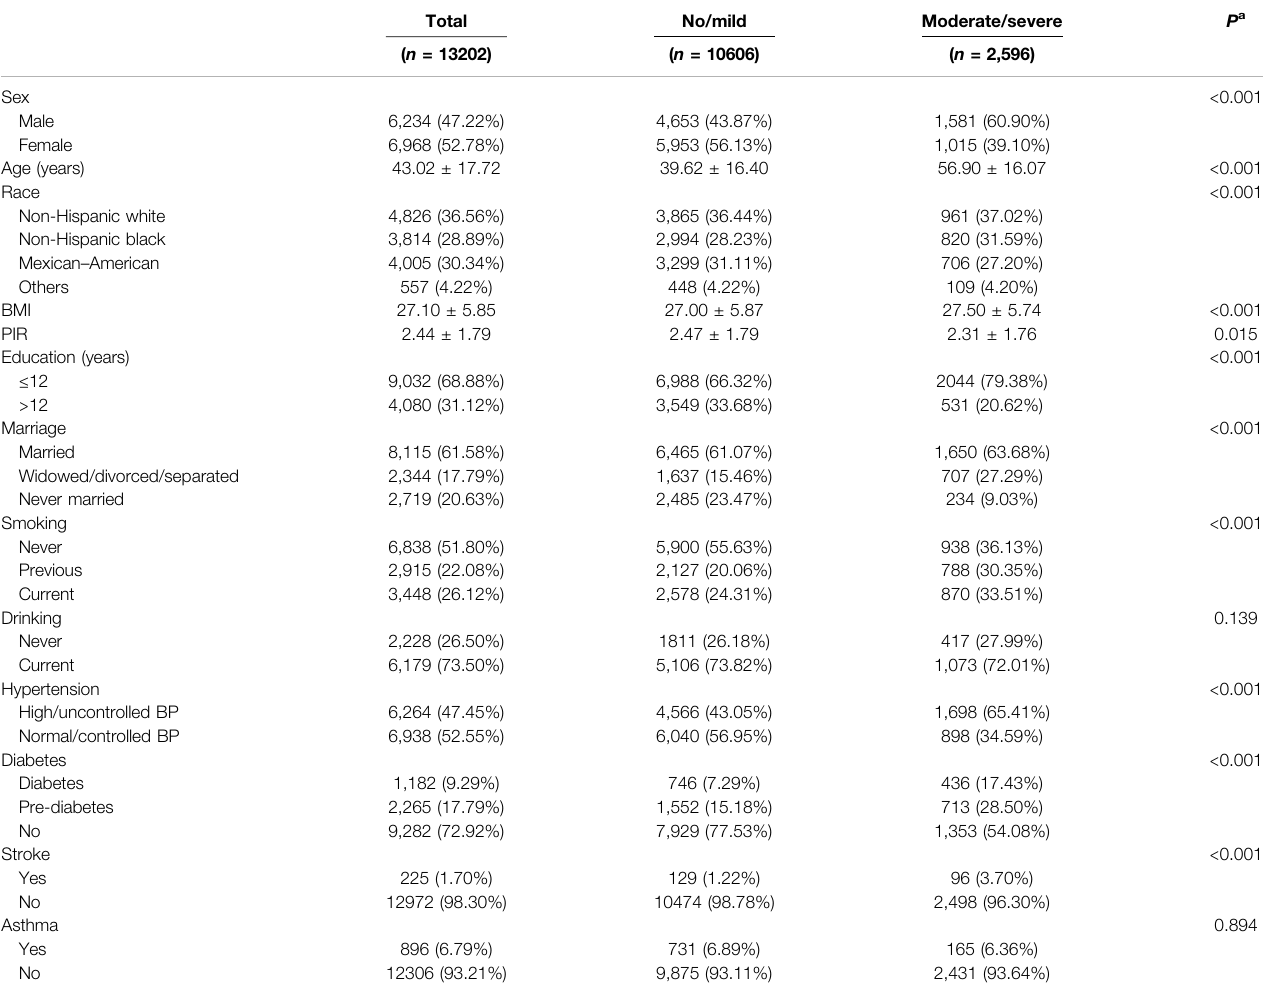
TABLE 1 | Weighted comparison in basic